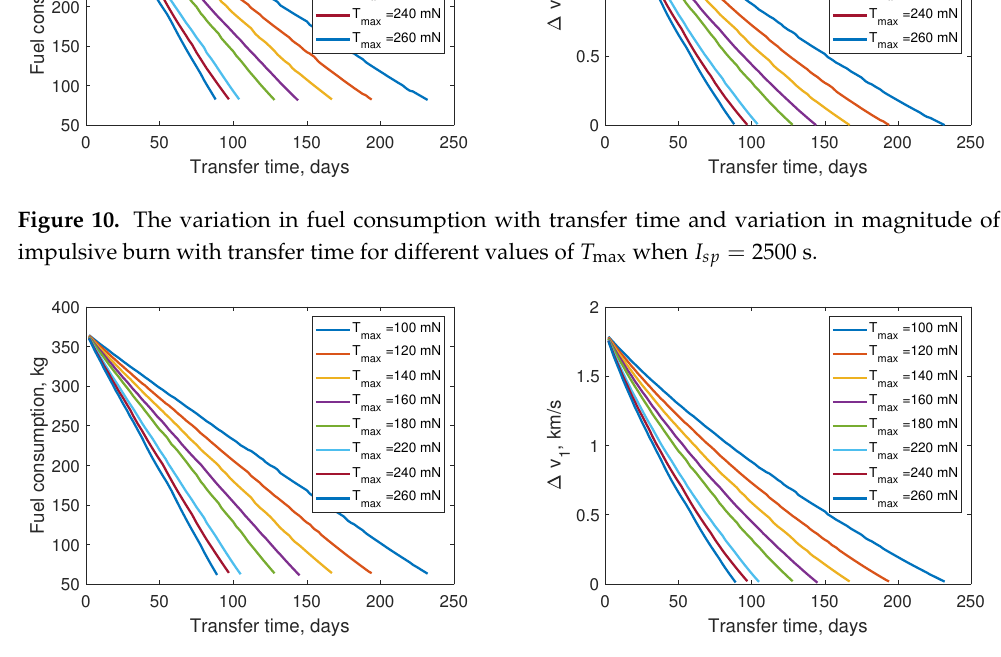
Figure 11. The variation in fuel consumption with transfer time and variation in magnitude of impulsive burn with transfer time for different values of T max when I sp = 3500 s.